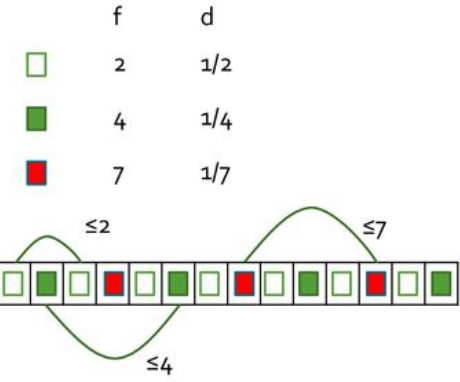
Figure 1. An example of input instance for the Pinwheel problem where V = ( 2,4,7 ) and hence D = 1/2 + 1/4 + 1/7 ≈